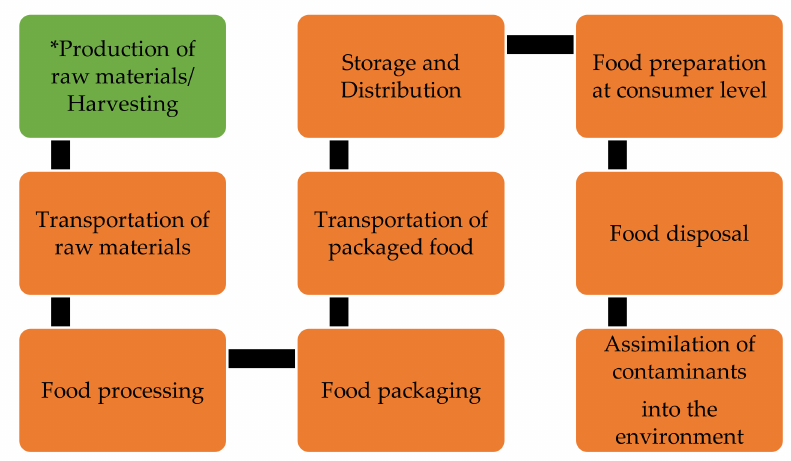
Figure 1. Key steps in food production, processing (farm-to-fork) till disposal. The figure is produced by